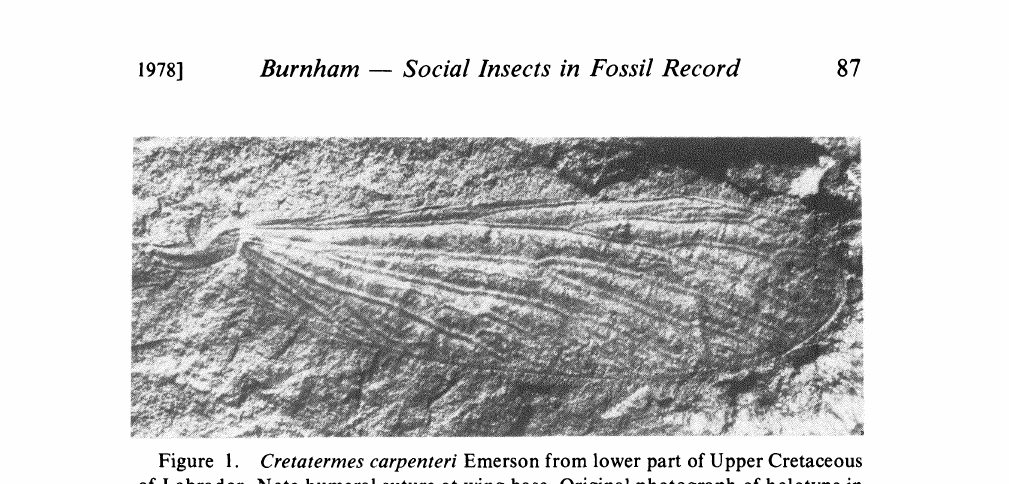
Figure 1. Cretatermes carpenteri Emerson from lower part of Upper Cretaceous of Labrador. Note humeral suture at wing base. Original photograph of holotype in Princeton Museum. Length of wing, 7.5